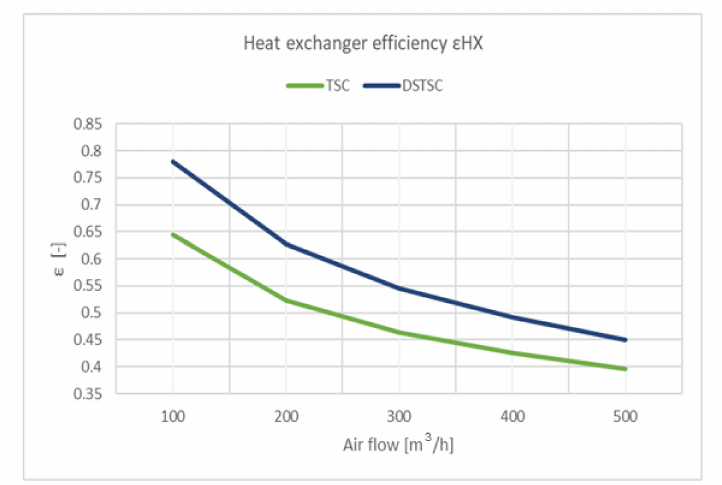
Figure 5. Heat exchanger efficiency ε HX .